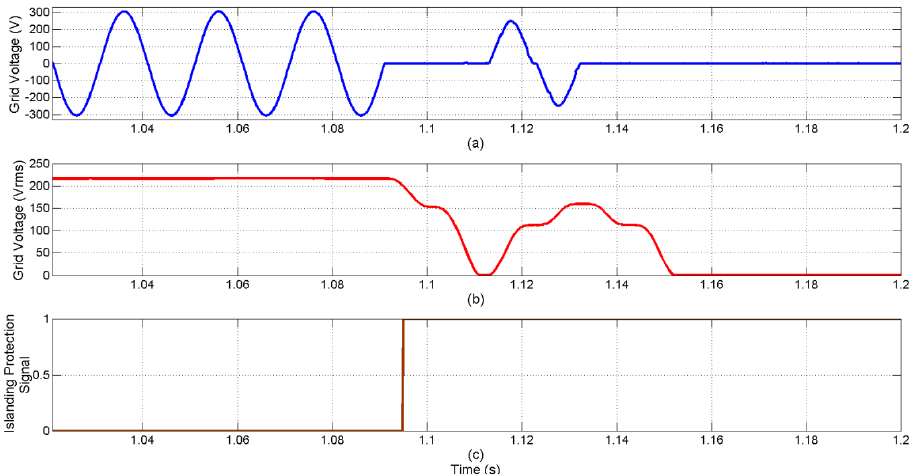
Figure 13. The waveform of the grid voltage when the power grid fails. ( a ) Grid voltage [V] ( b ) Grid voltage [Vrms] ( c ) Islanding protection signal.